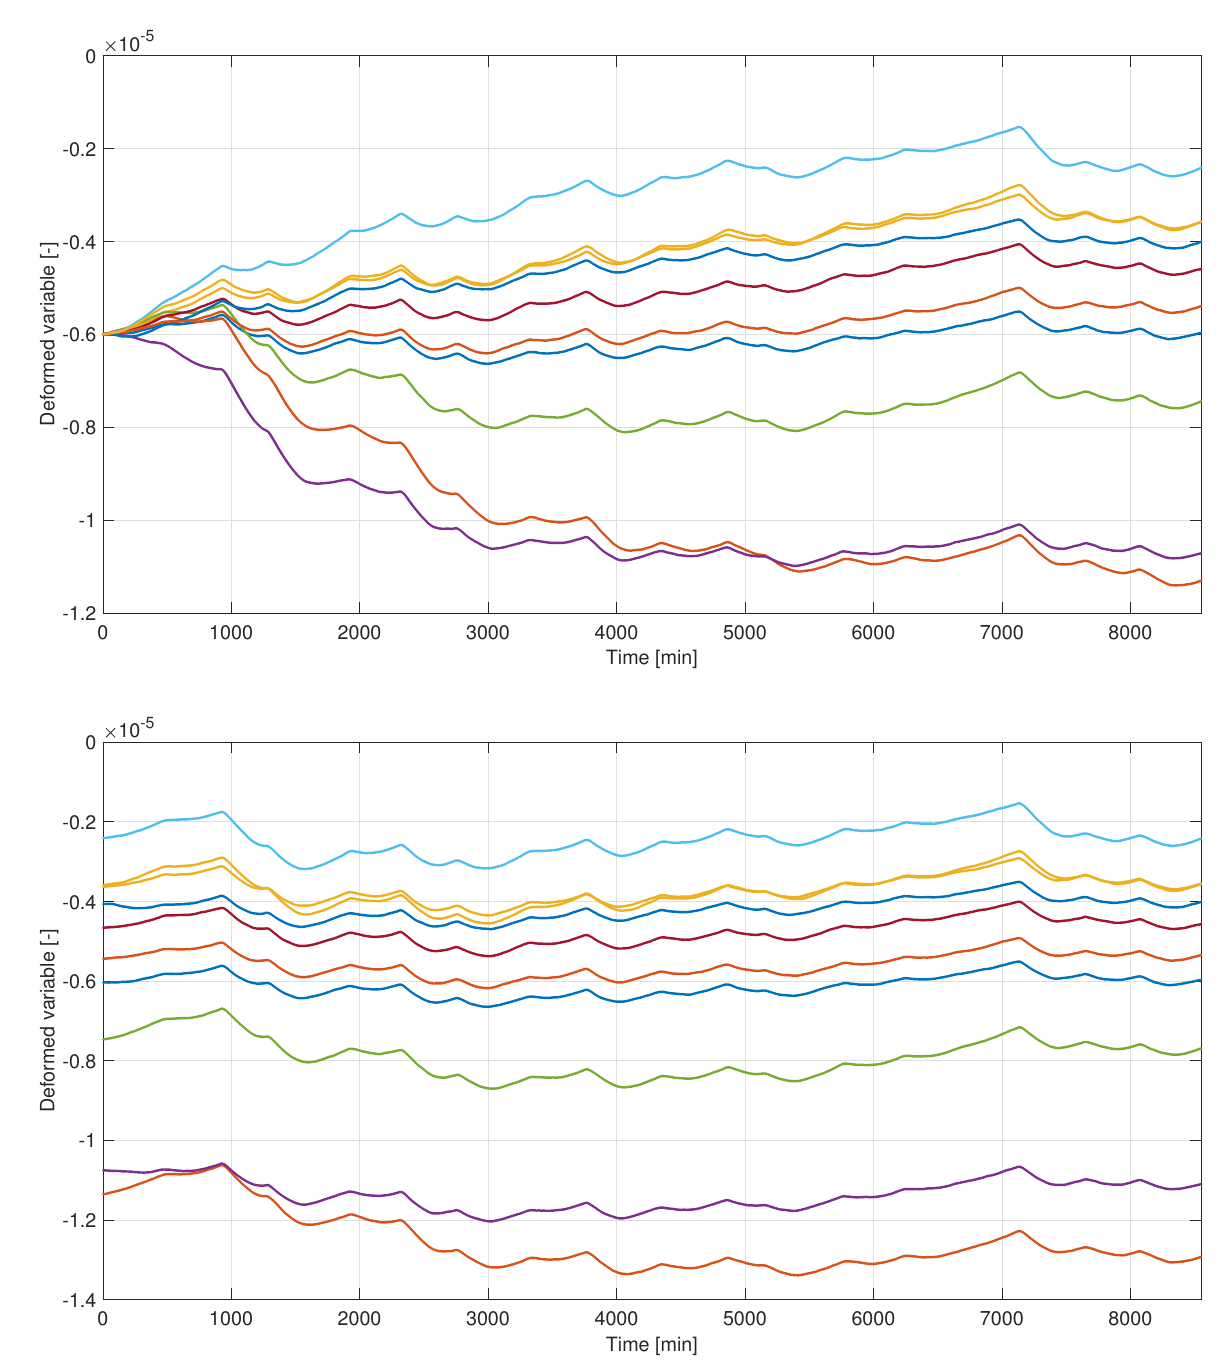
Figure 5. Evolution of the deform variable g associated with the closed-loop control. The top figure shows the slow adaptation case, while the bottom corresponds to the